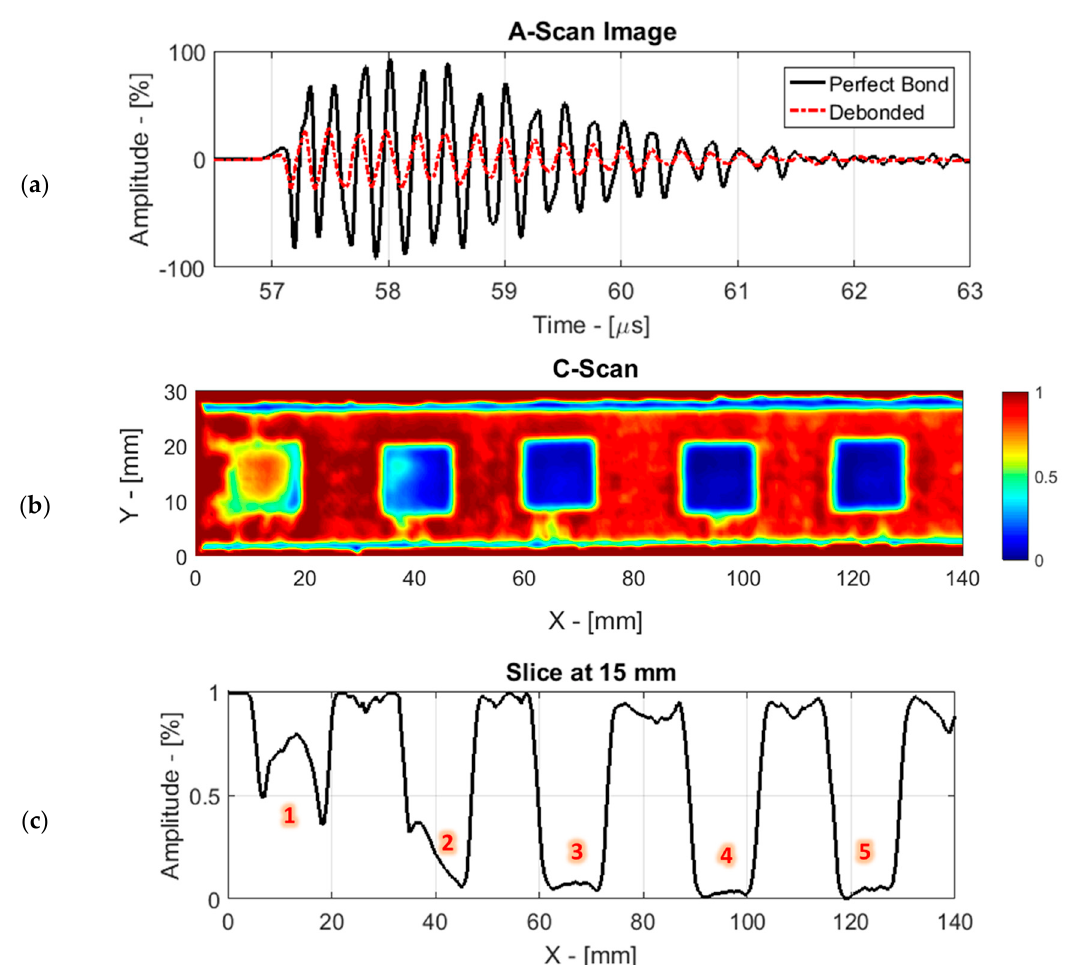
Figure 11. Immersion ultrasonic through-transmission results: ( a ) A-scan; ( b ) C-scan; ( c ) slice from the middle of the defects.